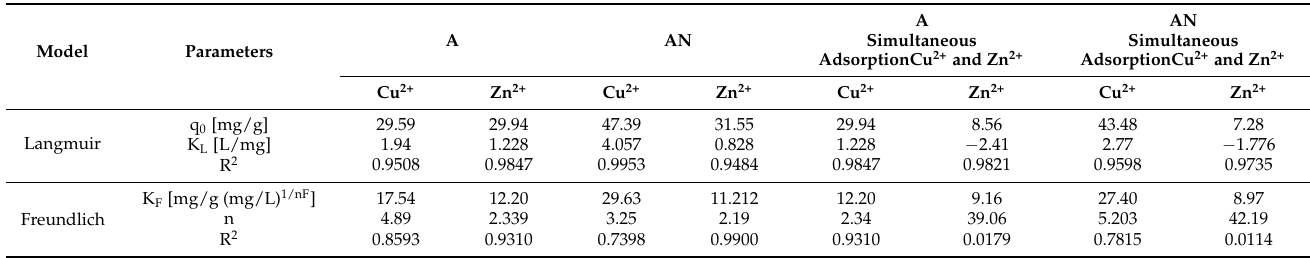
Figure 4. The effect of temperature on ( a ) Cu(II) ions’ adsorption, ( b ) Zn(II) ions’ adsorption, and ( c ) simultaneous adsorption of Zn(II) and Cu(II) (pH: 6, heavy metal ions’ concentration: 10 mg/L, mass of sorbent: 0.01 g, time 240 min, shaking speed 180 rpm). Table 5. Langmuir and Freundlich isotherm parameters and correlation coefficients for the adsorption of Cu 2+ and Zn 2+ on the activated